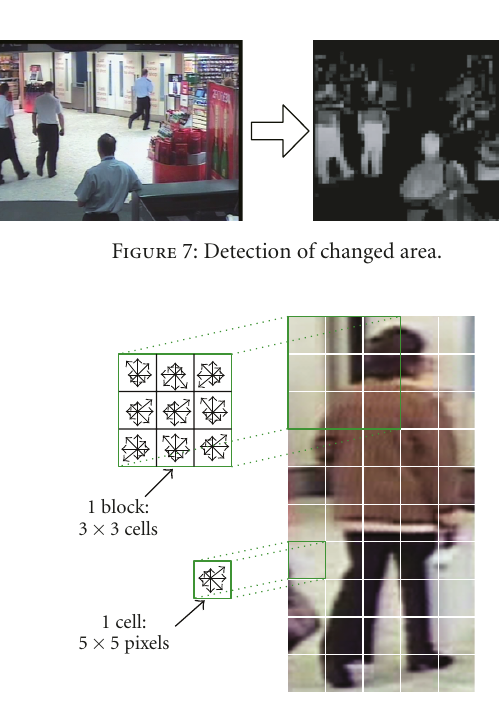
Figure 8: Cells and